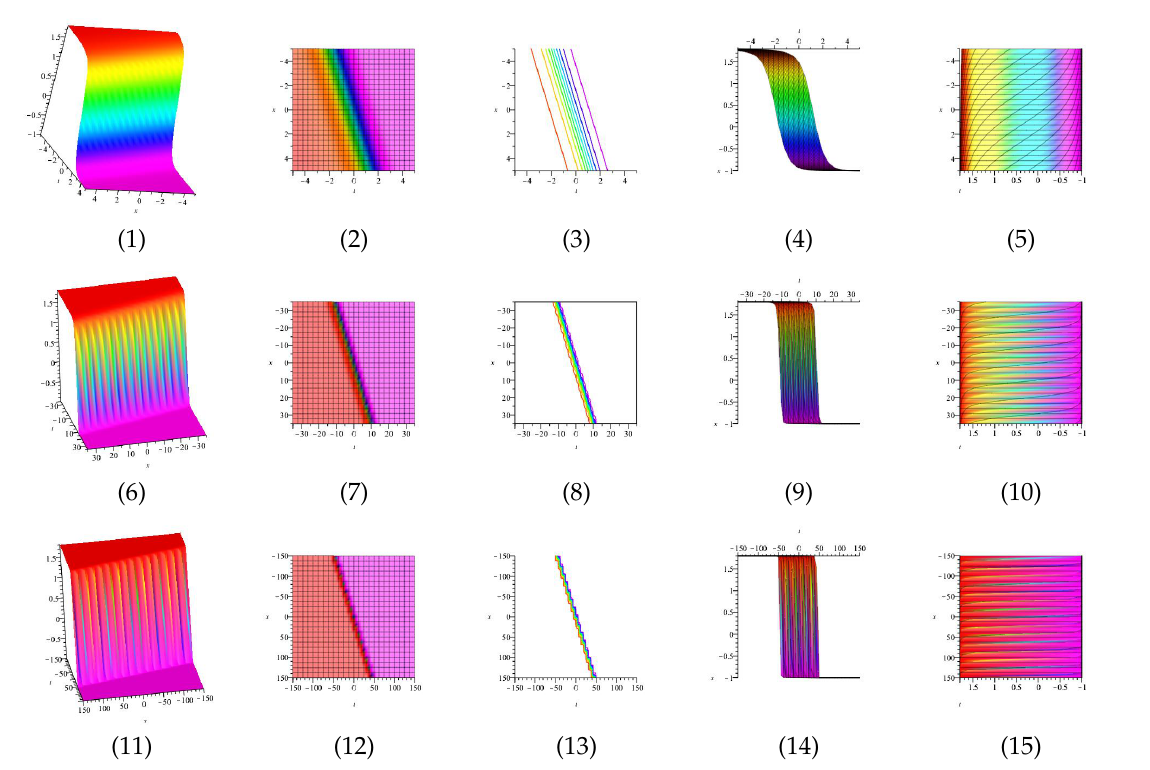
Figure 19. The 3D and 2D with the diagram of equation u (cid:48) S 1 = 0.20, S 2 = 0.70, and S 3 = − 0.50. ( 2 ) , ( 7 ) , ( 12 ) , ( 4 ) , ( 9 ) , ( 14 ) and ( 5 ) , ( 10 ) , ( 15 ) display z − axis, x − axis, y − axis orientations, respectively, and ( 3 ) , ( 8 ) , ( 13 ) are contour plots, in different domains.